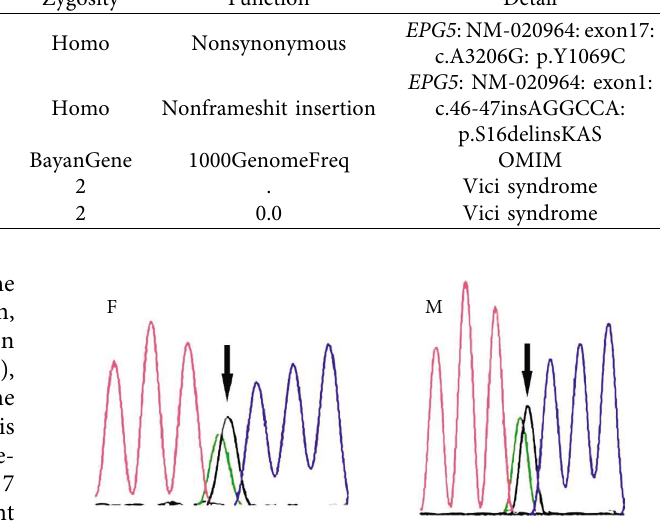
Figure 2: Heterozygous mutation c.A3206G (p.Y1069C; Het) on EPG5 gene has been detected in father (F) and in mother (M) of this case (5-year-old girl) by DNA sequencing of the PCR-amplified product of the EPG5 exon 17. Therefore, her parents are the carrier of this mutation. Since the parent found to be the carrier of the above mutation, the patient is very likely affected with Vici syn- drome. Heterozygous mutation c.A3206G (p.Y1069C; Het) on EPG5 gene has been detected in the 5-year-old